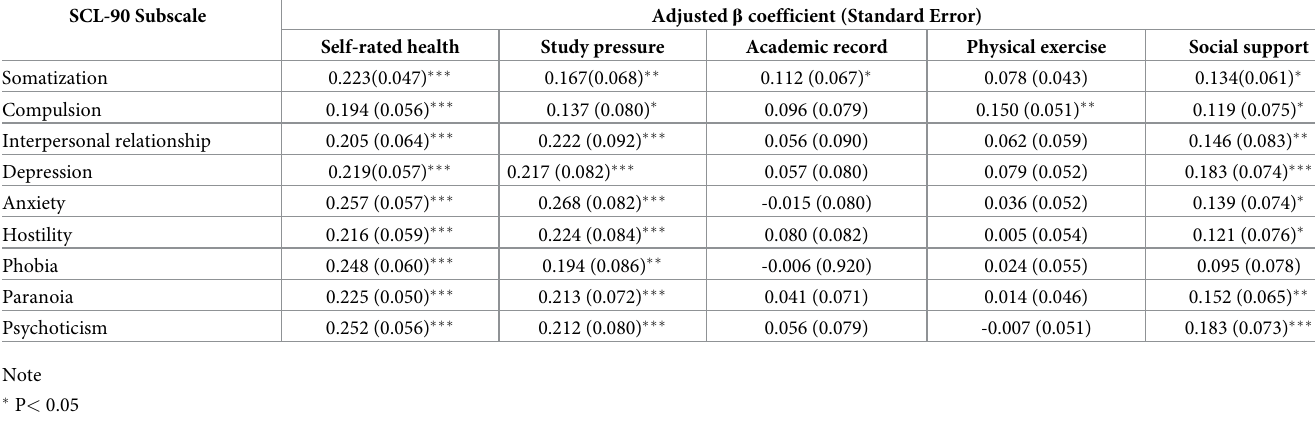
Table 4. Results of multivariate linear regression modeling on SCL-90 subscale